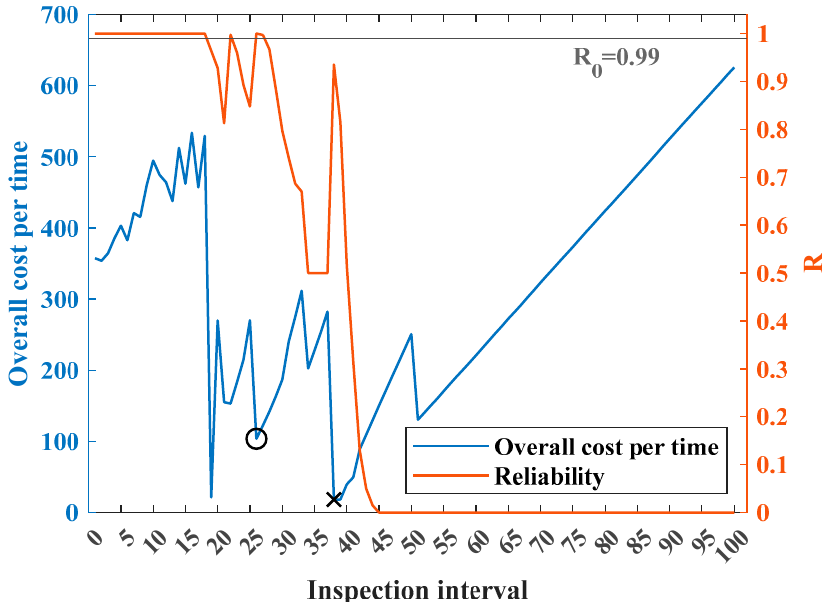
Figure 5. The reliability and overall cost per time when different inspection intervals are used.